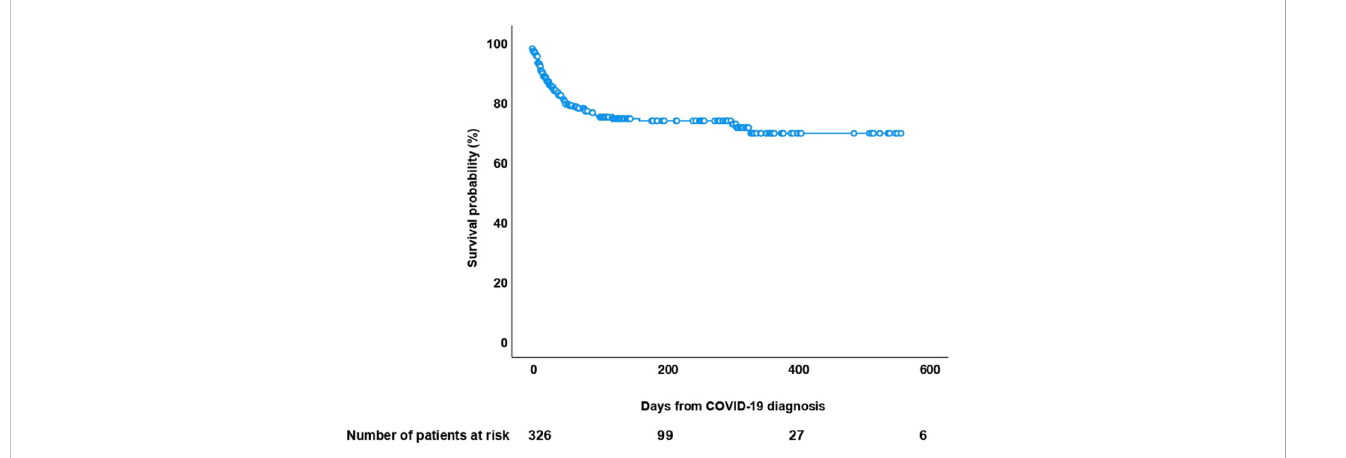
FIGURE 1 Kaplan-Meier overall survival curve after diagnosis of COVID-19 infection in 326 allogeneic HSCT